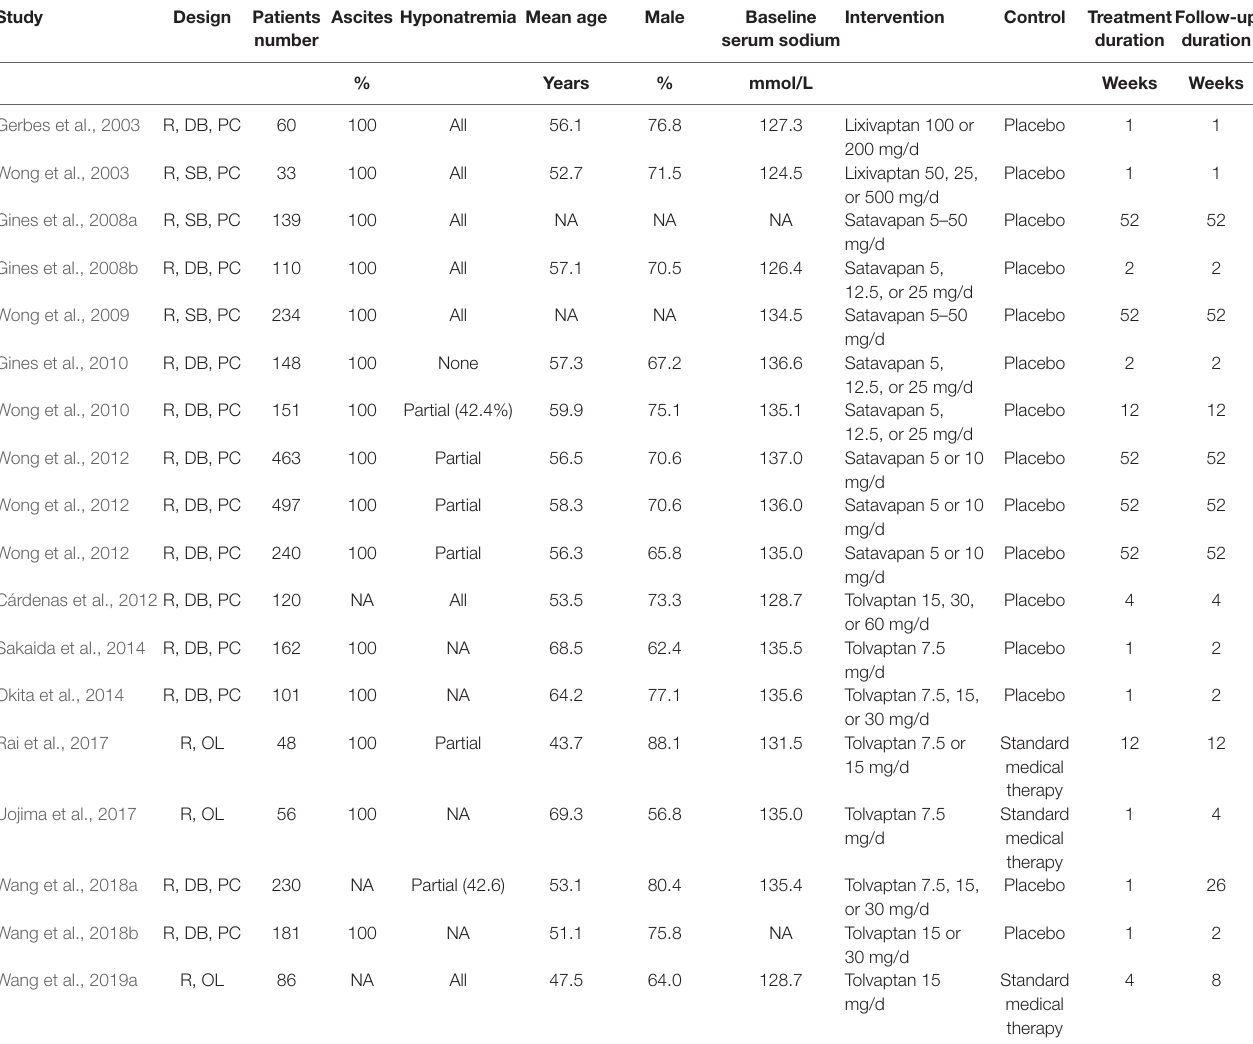
TABLe 1 | Characteristics of the included randomized control trials. Study Design Patients Ascites Hyponatremia Mean number